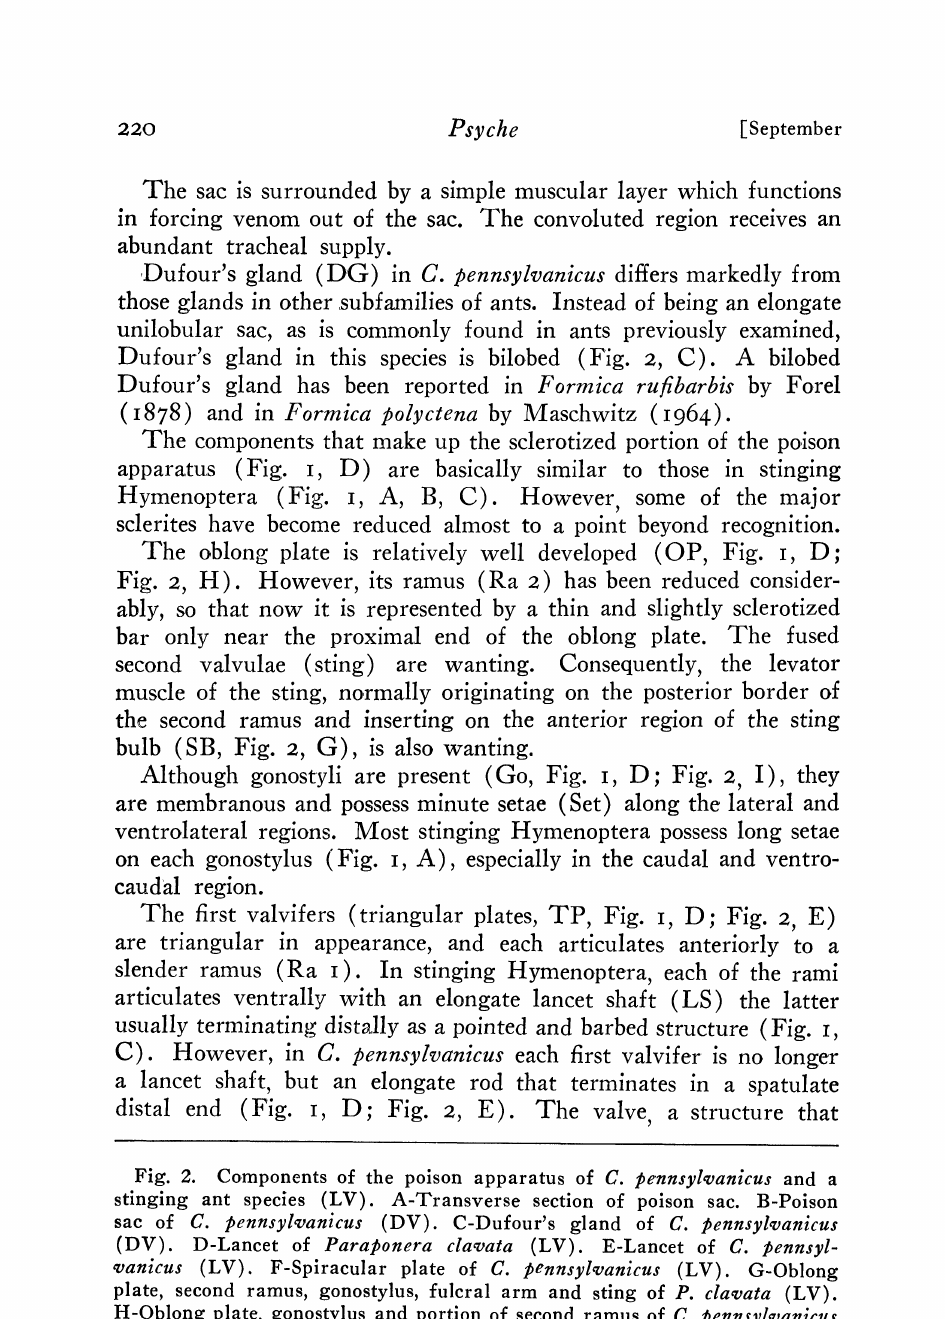
Fig. 2. Components of the poison apparatus of C. e’nnsylanicus and a stinging ant speeies (LV). A-Transverse section of poison sac. B-Poison sac of C. lennsylanicus (DV). C-Dufour’s gland of C. lennsylanicus (DV). D-Lancet of Paralonera claata (LV). E-Lancet of C. kennsyl- anicus (LV). F-Spiraeular plate of C. kennsylanicus (LV). G-Oblong plate, seeond ramus, gonostylus, fuleral arm and sting of P. claata (LV). H-Oblong plate, gonostylus and portion of second ramus of C. ennsylanicus (LV). I-Gonostylus of C. pennsylanicus